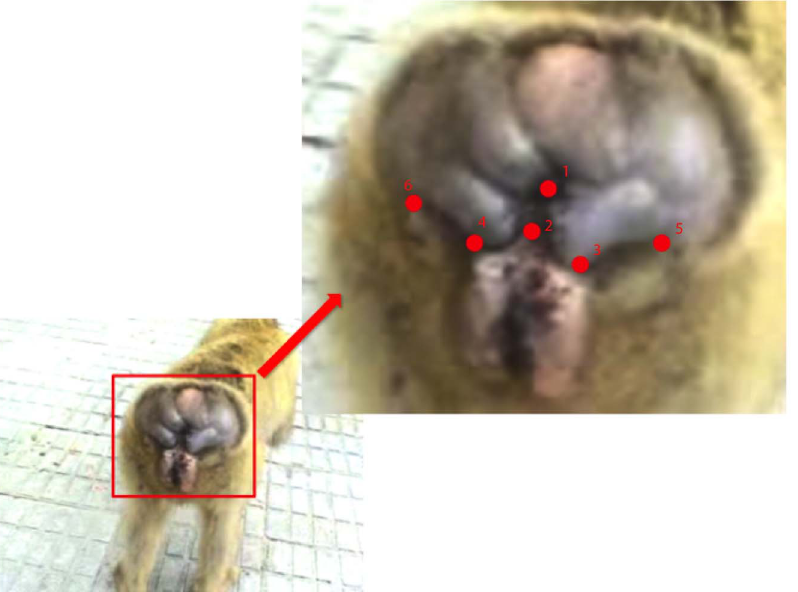
Figure 1. Identifying homologous points. The six homologous landmarks on the perineal swelling of a female Barbary macaque. In addition to the primary landmarks used for transformation parameter estimation, a number of secondary landmarks were also digitized for use in volume estimation. These might include scar or wrinkle termini or even dirt or trash affixed to the surface of the swelling. The only requirement of these landmarks is that they are visible and positionally stable in multiple views of the individual at the time the images are recorded.